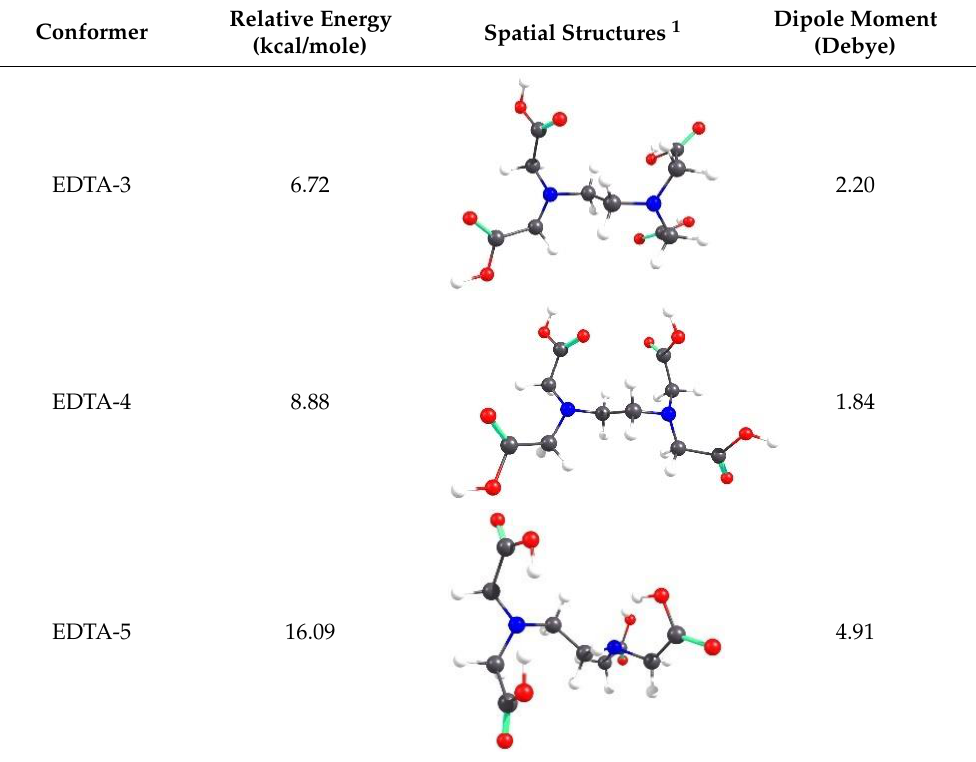
1 Legend colors: grey-C, red-O, blue-N, white-H.